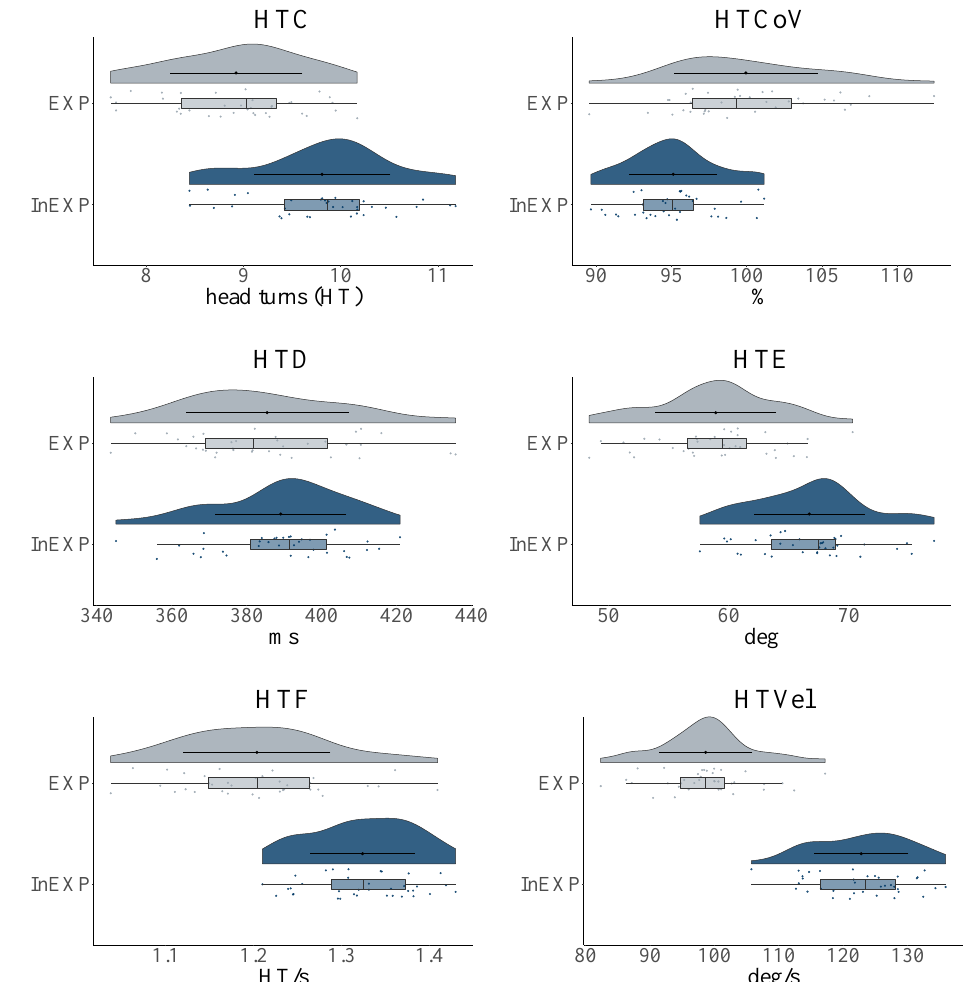
Figure 4. Illustration of the data distribution and probability density for inexperienced (InEXP) and experienced (EXP) soccer players of the individual head turn characteristics. Head turn count (HTC); head turn coefficient of variation (HTCoV); head turn duration (HTD); head turn excursion (HTE); head turn frequency (HTF) and head turn velocity (HTVel).